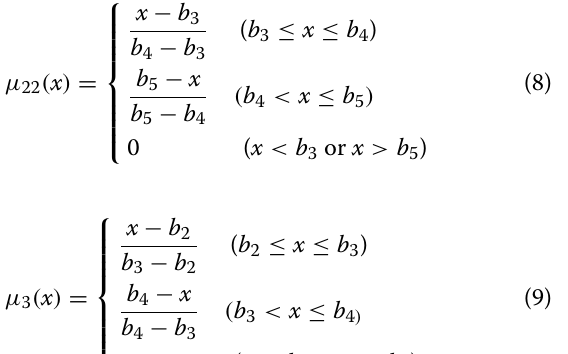
Evaluation model of feed